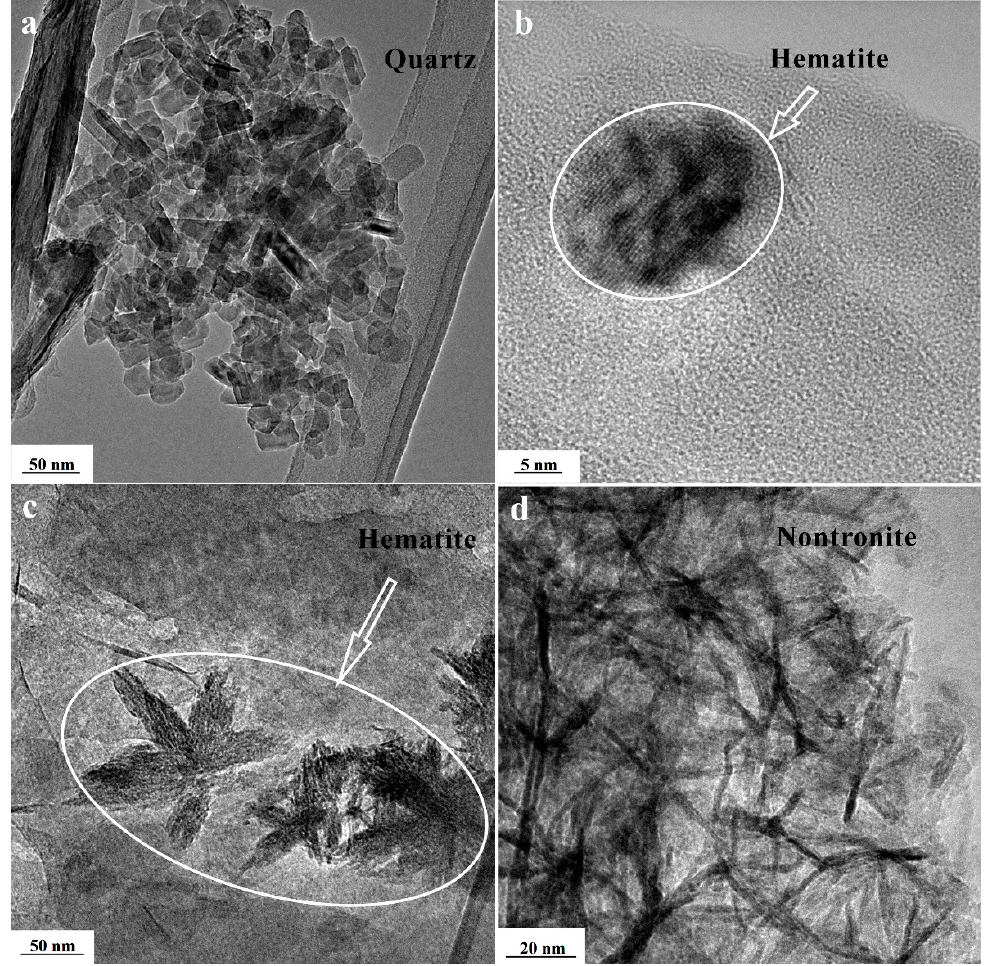
Figure 4. TEM images of mineral inclusions—( a ) quartz; ( b ) hematite; ( c ) hematite; and ( d ) nontronite.